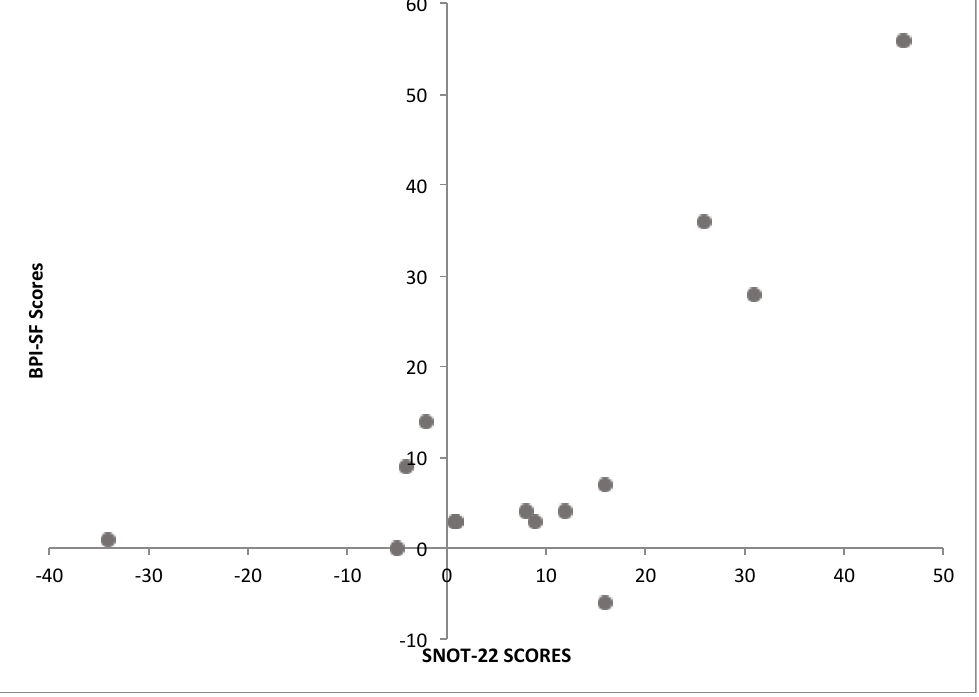
Figure 5. Correlation between SNOT-22 scores and BPI-SF scores ( R 2 = 0.51).